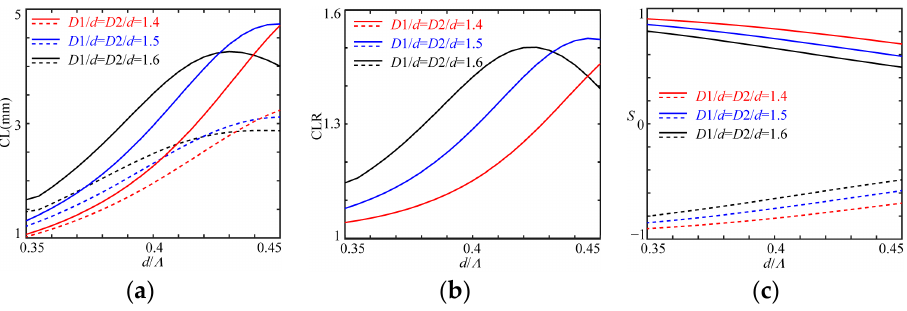
Figure 5. The variation relations of CLs ( a ), CLRs ( b ) and S s ( c ) with d / Λ